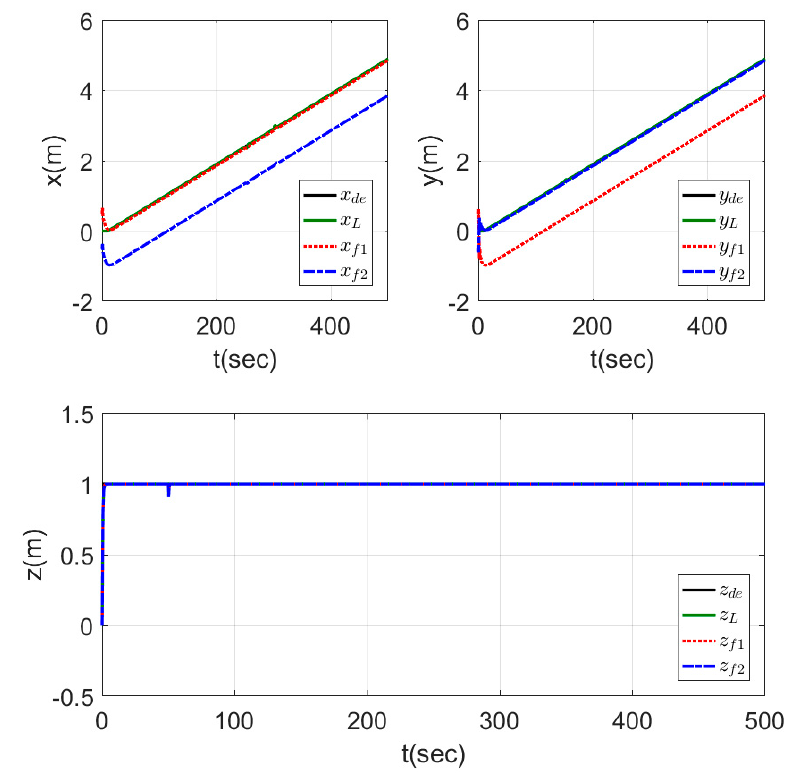
Figure 21. Time response of fixed formation tracking with disturbances.